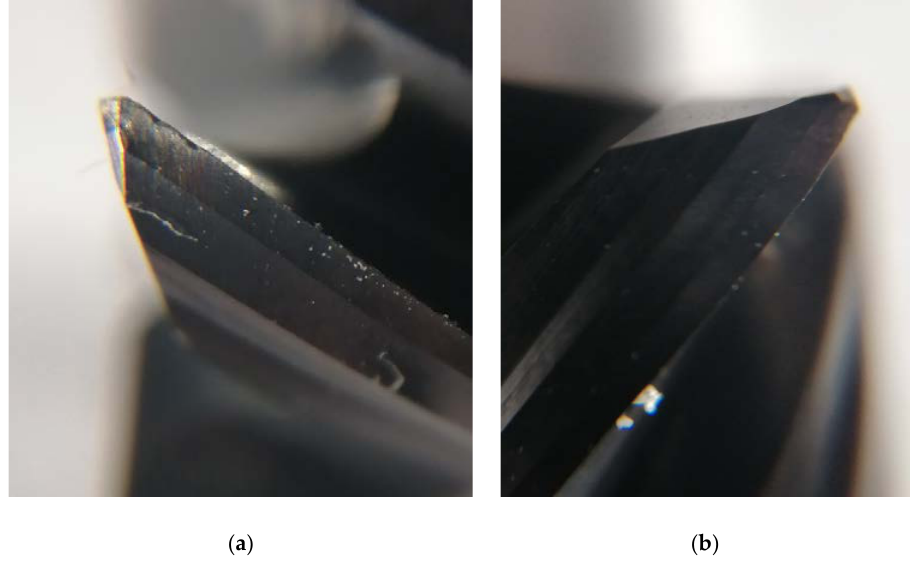
Figure 2. ( a ) Worn and ( b ) new cutting edge. Magnification × 12.